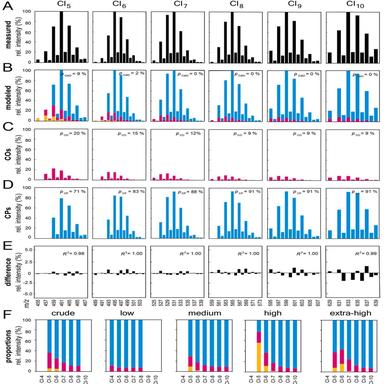
Deconvolution of interfered mass spectra of the purified single-chain C18-CP-material with a medium chlorination degree. Measured isotope clusters (A) are compared with modeled ones (B). Non-interfered signals of CdiOs (orange, B), COs (magenta, C) and CPs (blue, D) are displayed. Respective proportions (pCP. pCO, pCdiO) are indicated. Differences of modeled (B) and measured (A) isotope clusters are indicated for each signal (E). The coefficients of determination R2 of the models are displayed (E). CP-, CO-